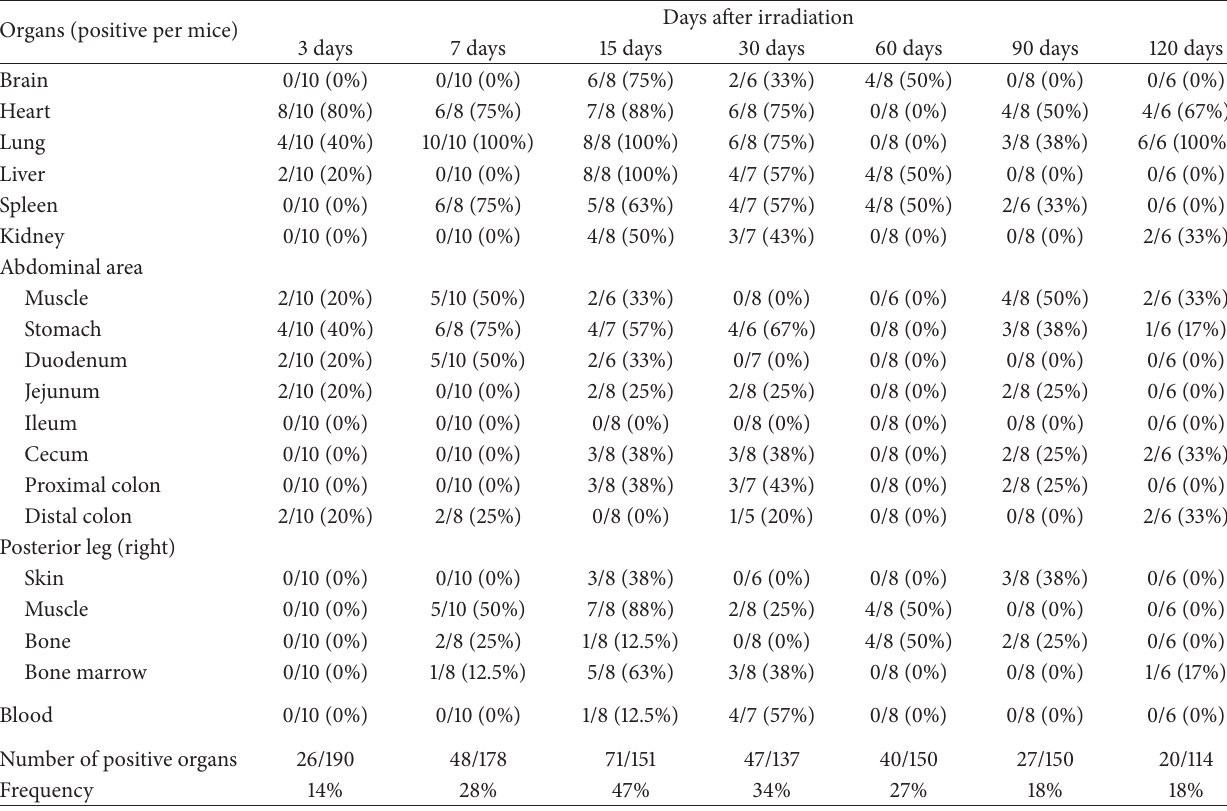
Table 4: Kinetics of hMSC biodistribution after total body irradiation (TBI) at 3.5 Gray. Organs (positive per